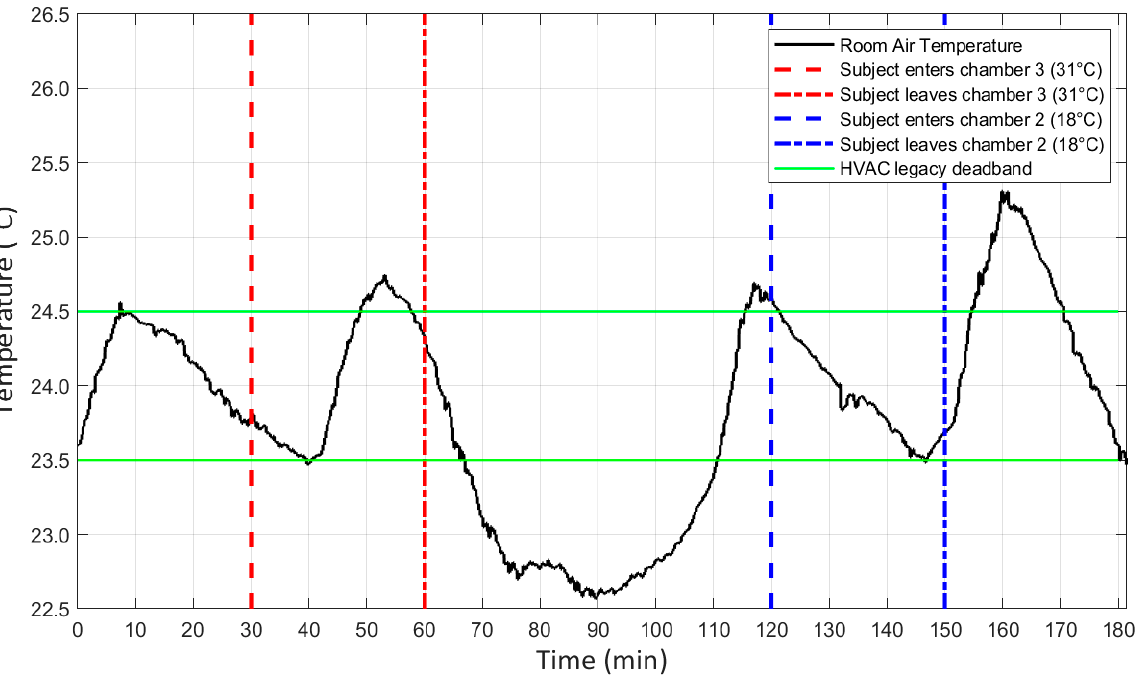
Figure 6. Thermostat measurements of room air temperature in Chamber 1 for test subject 2 show a decrease in room air temperature as the subject returns from Chamber 3 (31 °C) and the sensor/controller cools the space, and an increase in room air temperature as the subject returns from Chamber 2 (18 °C) and the sensor/controller heats the space.